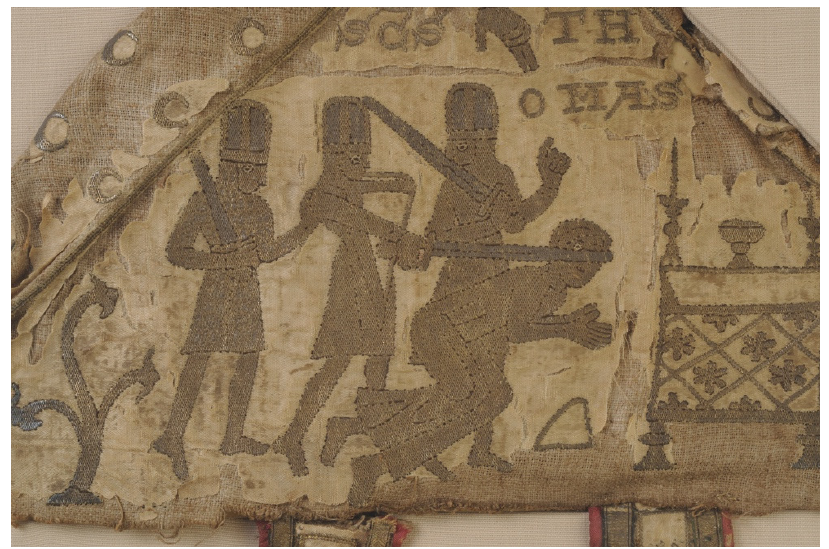
Figure 2. Jacques de Vitry’s Mitre, detail of the front face: Thomas Becket murder. Donated by the Sisters of Notre-Dame de Namur, coll. King Baudouin Foundation, on deposit at the Société Ar- chéologique of Namur and exhibited at the TreM.a—Musée des Arts Anciens, Namur, Belgium © Hughes Dubois.